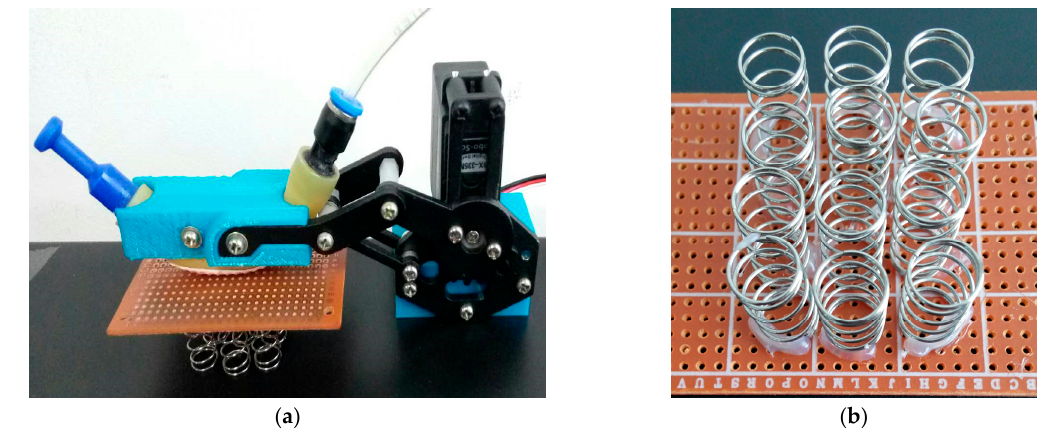
Figure 9. The experiment of detecting softness. ( a ) the experiment; ( b ) the softness simulated by